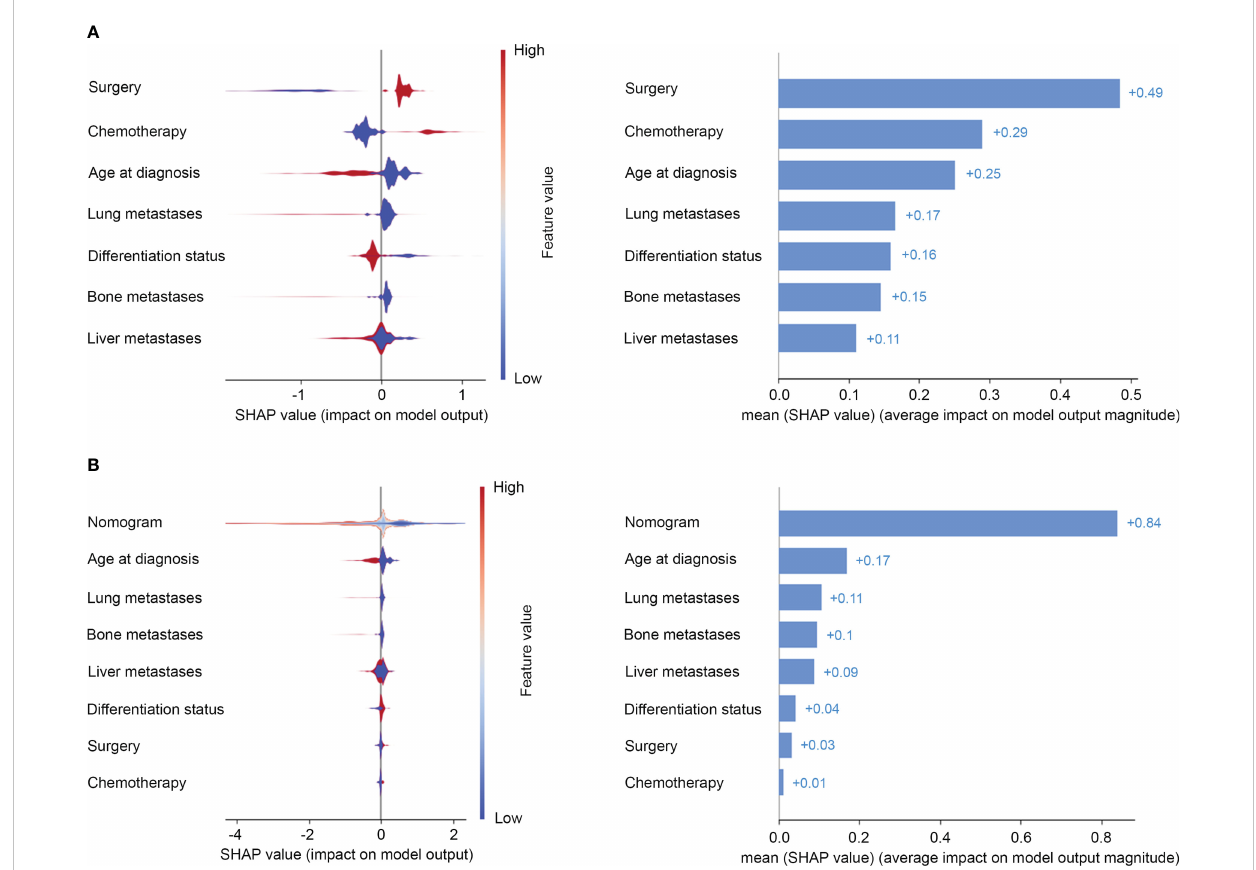
FIGURE 4 Risk estimates on clinical-pathologic features (A) and the risk model (B) by Shapley values to predict the risk of all-cause mortality. On the X-axis, the contribution of each feature is shown. A feature with a positive shapley value will favorably impact the prediction (decrease the risk of all-cause mortality). The in fl uence of the value of the feature itself is shown on the Yaxis, for example, for nomogram, a high value (in red) is associated with a positive shapley value that will decrease the risk of all-cause mortality, while a low value (in blue) will increase the shapley value and the risk of all- cause